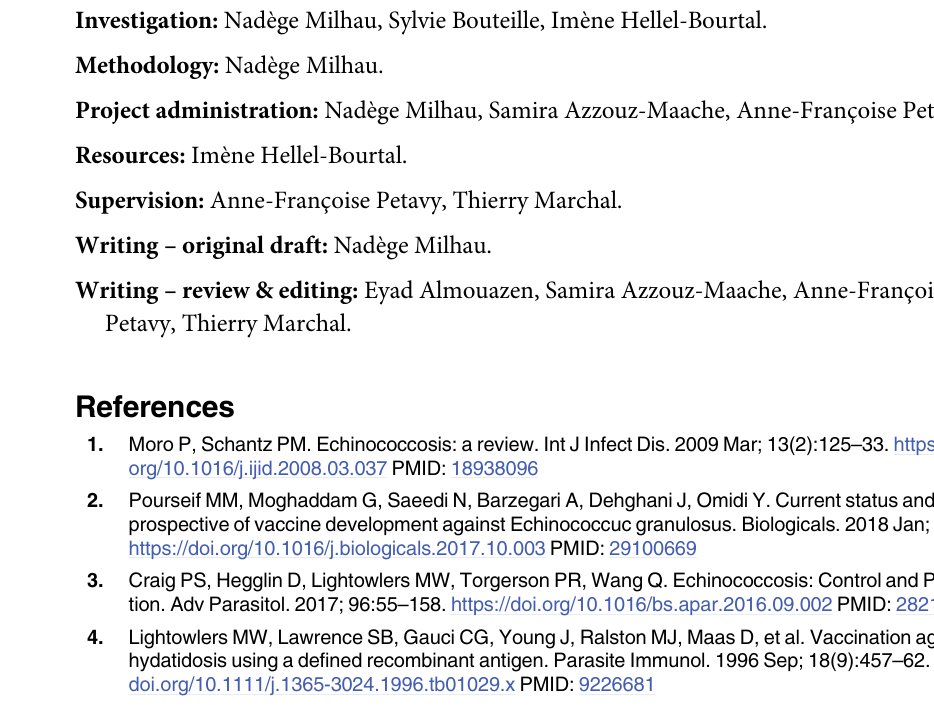
S3 Fig. Example of cytometry profiles of CD80, MHC II, CD40 and CD86 expression obtained on cMoDCs 24h after of challenge with (A) PBS, (B) LPS, (C) Blank-NPs, (D) Eg Trp alone,